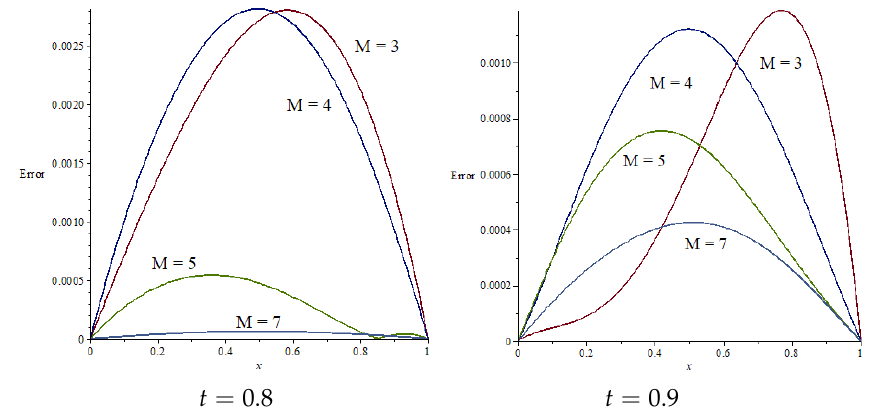
Figure 3. Graphs of absolute errors for Fisher equation at t = 0.5 and t = 0.7.